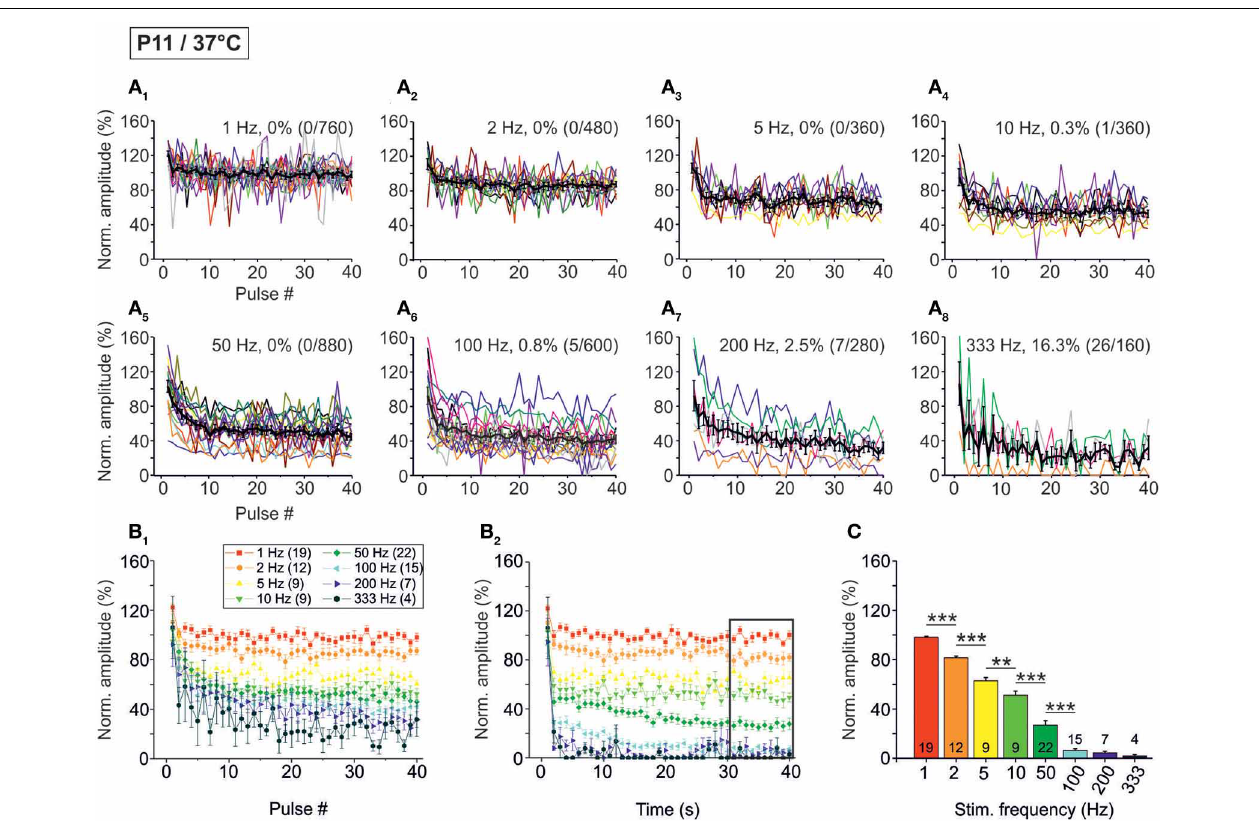
FIGURE 3 | Population data illustrating the frequency-dependent time course of glycinergic IPSC peak amplitudes at P11/37 ◦ C. (A 1 –A 8 ) Color-coded plots for all recorded LSO neurons at eight stimulation frequencies ( n = 4–22, cf. inset in panel B 1 ), depicting the time course of IPSC amplitudes in response to the first 40 stimuli. In each panel, the mean values ± s.e.m. are shown in black. The failure rate (%) and the ratio failures/events across neurons are also provided in each panel. (B 1 ) Mean values ± s.e.m. of the first 40 IPSCs obtained in response to the eight